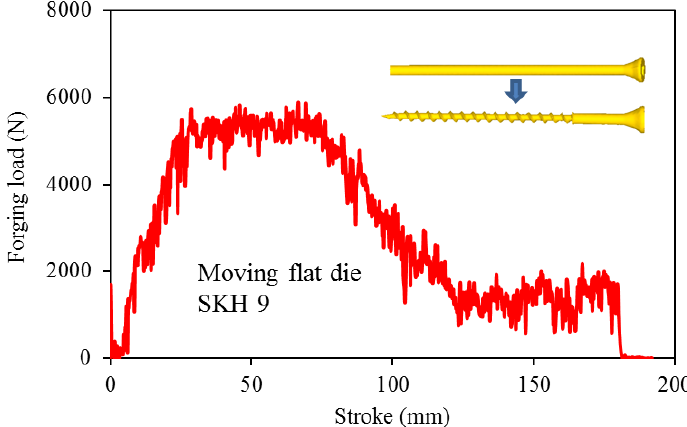
Figure 11. Detail of simulated workpieces and actual sheet metal tapping screw.